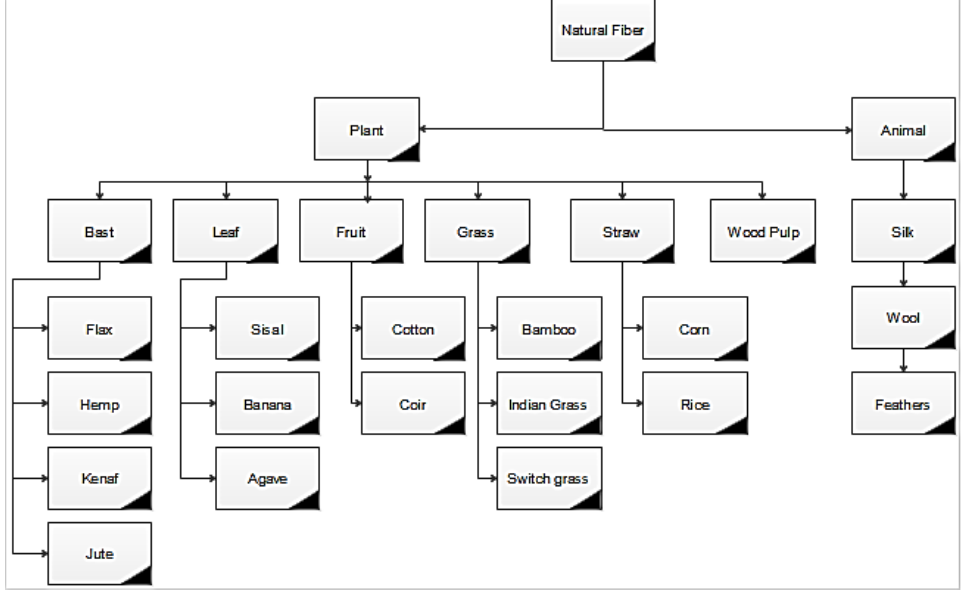
Figure 6. Classification of natural fibre. Adapted with the permission from Reference [19]. Copyright 2011 John Wiley and